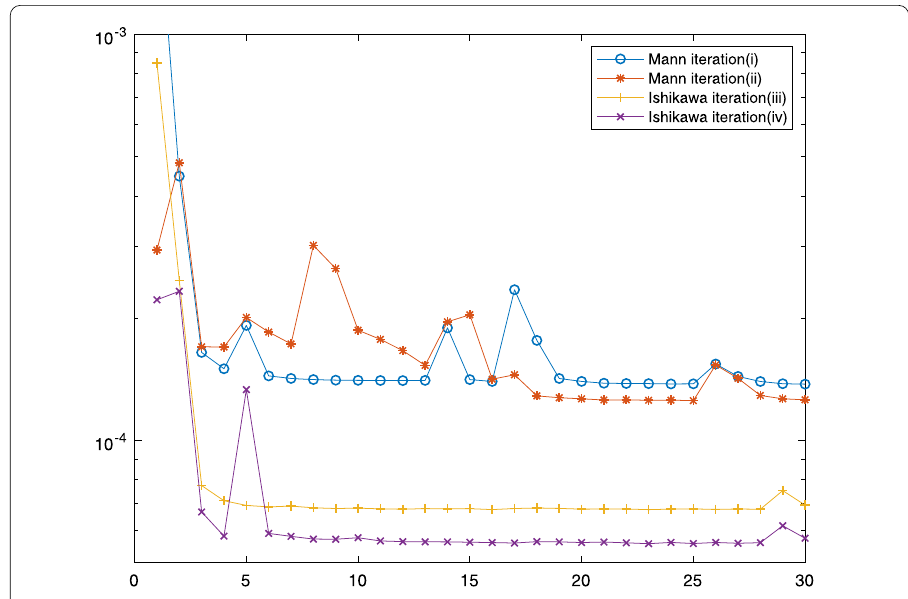
Figure 3 CPU time for Mann iterations and Ishikawa iterations with x 0 = 0.5